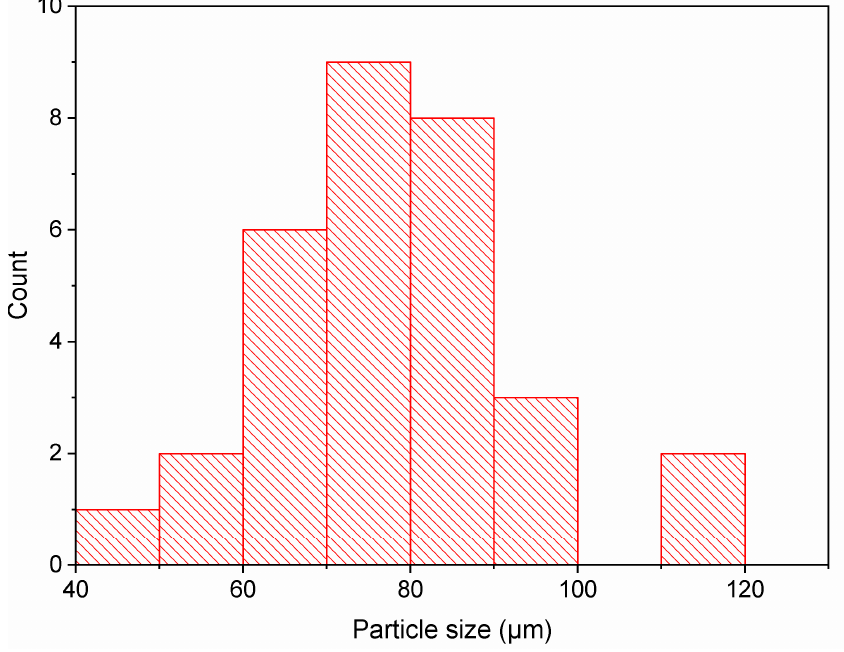
Figure 11. Particle size distribution.